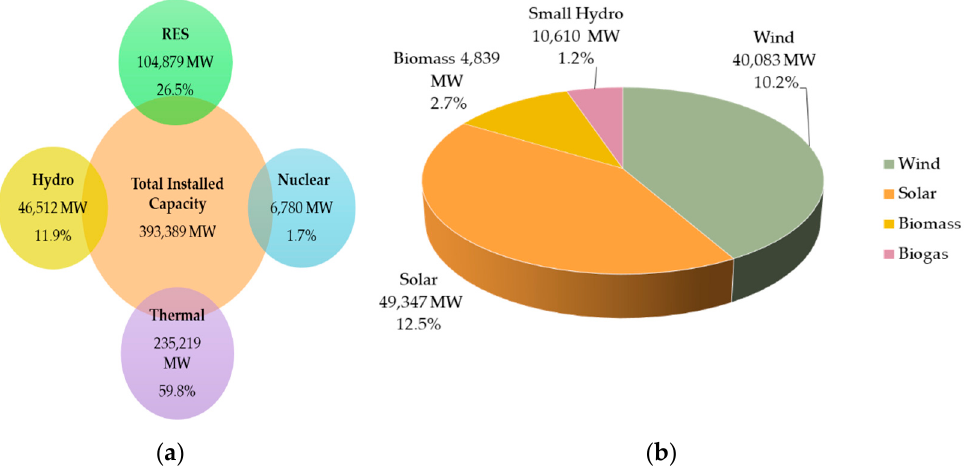
Figure 10. ( a ) Total installed capacity as on 31 December 2021 (Ref: Ministry of Power); ( b ) RES status as at 31 December 2021 (Ref: MNRE); Source: Global Wind Report 2021. Source: Ministry of Power, Central Electricity Authority, Government of India [41].